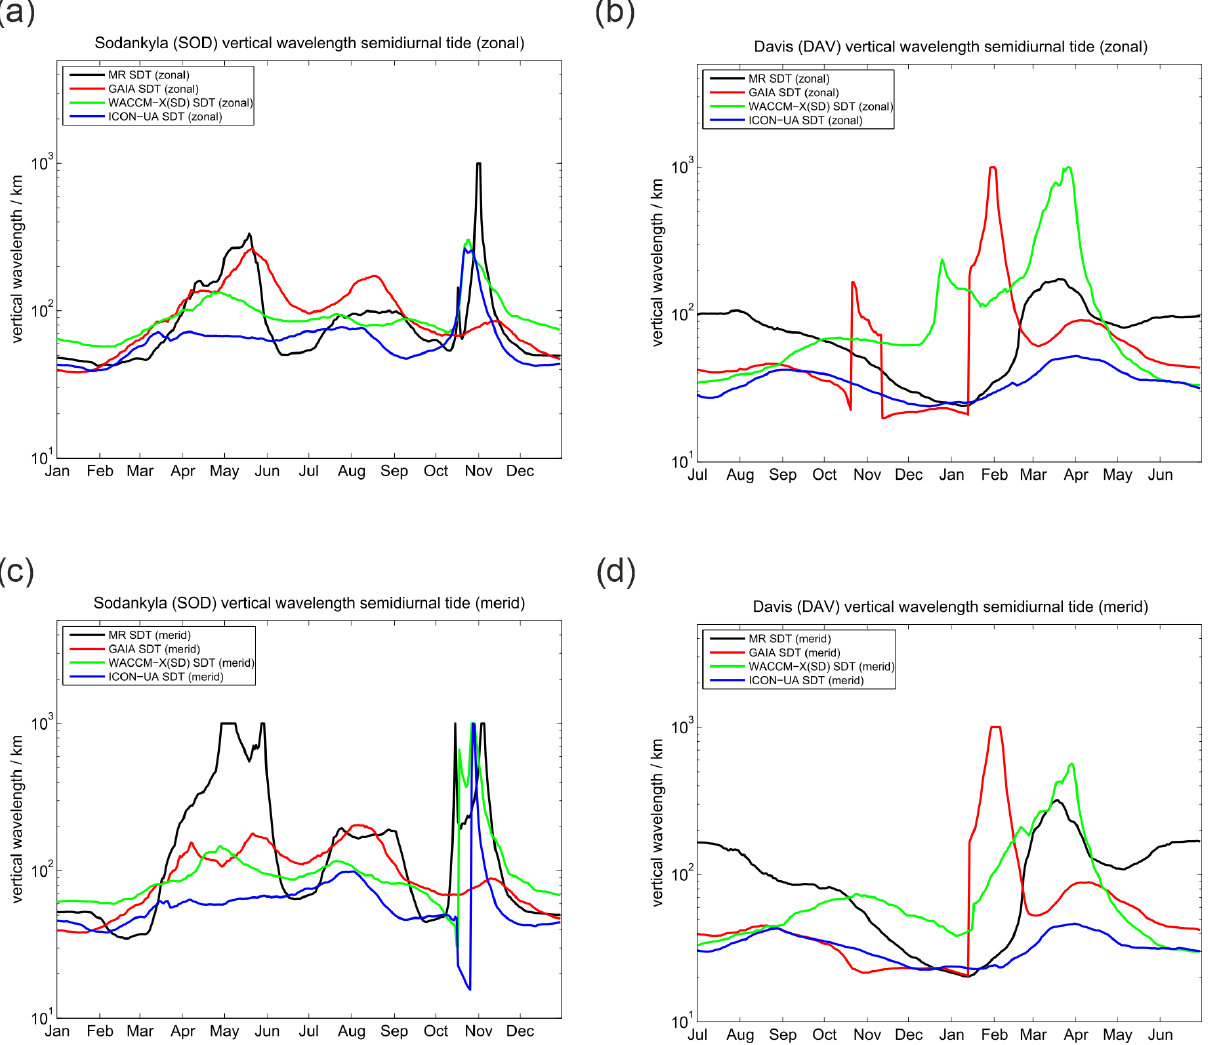
Figure 8. The same as Fig. 5, but for the semidiurnal tidal vertical